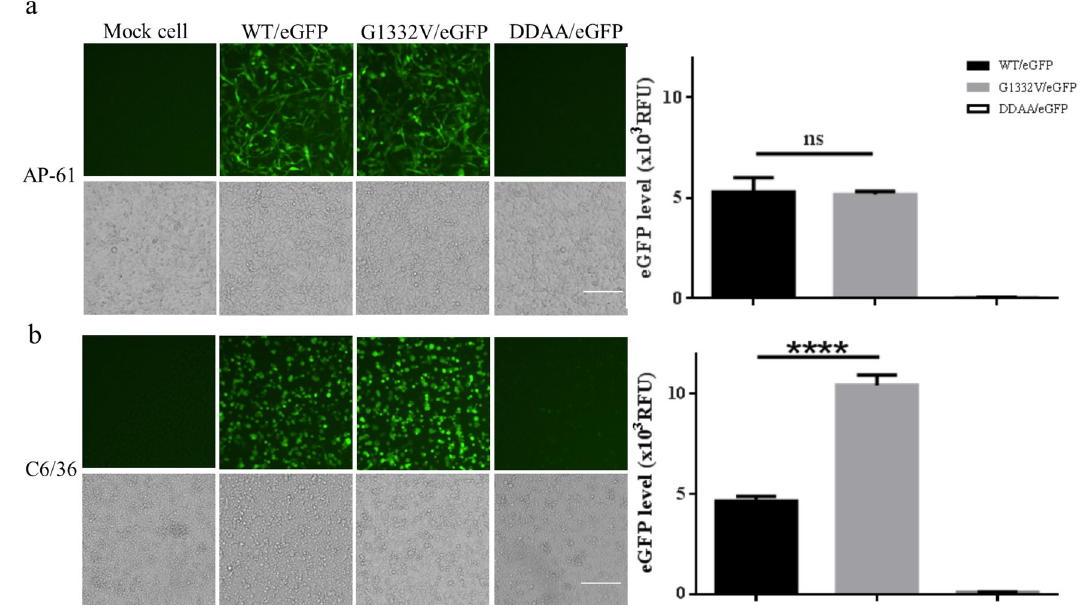
Figure 6. Autonomous CHIKV replicon-mediated eGFP expression of replicon variants in mosquito cell lines. AP-61 ( a ) or C6/36 ( b ) cells were transduced in triplicate using either WT/eGFP, G1332V/eGFP, or DDAA/ eGFP at indicated MOIs of 2. At 2 dpt, eGFP-expressing cells were photographed using green (upper panels) or bright field (lower panels) filters. Expression levels of eGFP were quantified (right part). Error bars represent the standard deviation. The statistical significance between WT/eGFP and G1332V/eGFP was analyzed using the Student’s t-test ( ns, not significant and **** p <